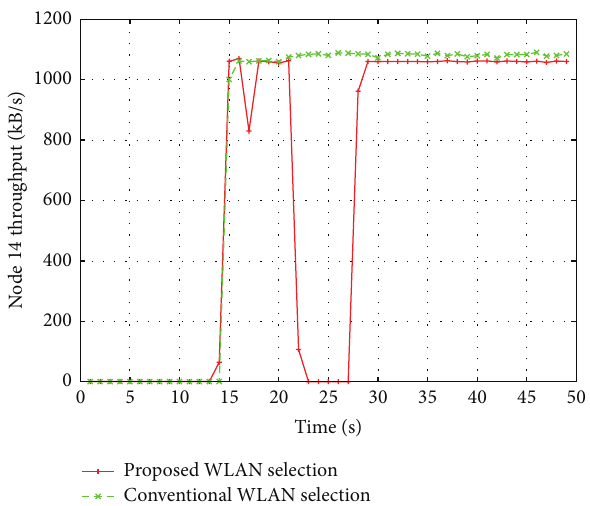
Figure 9: WiFi AP3 (Node 22)